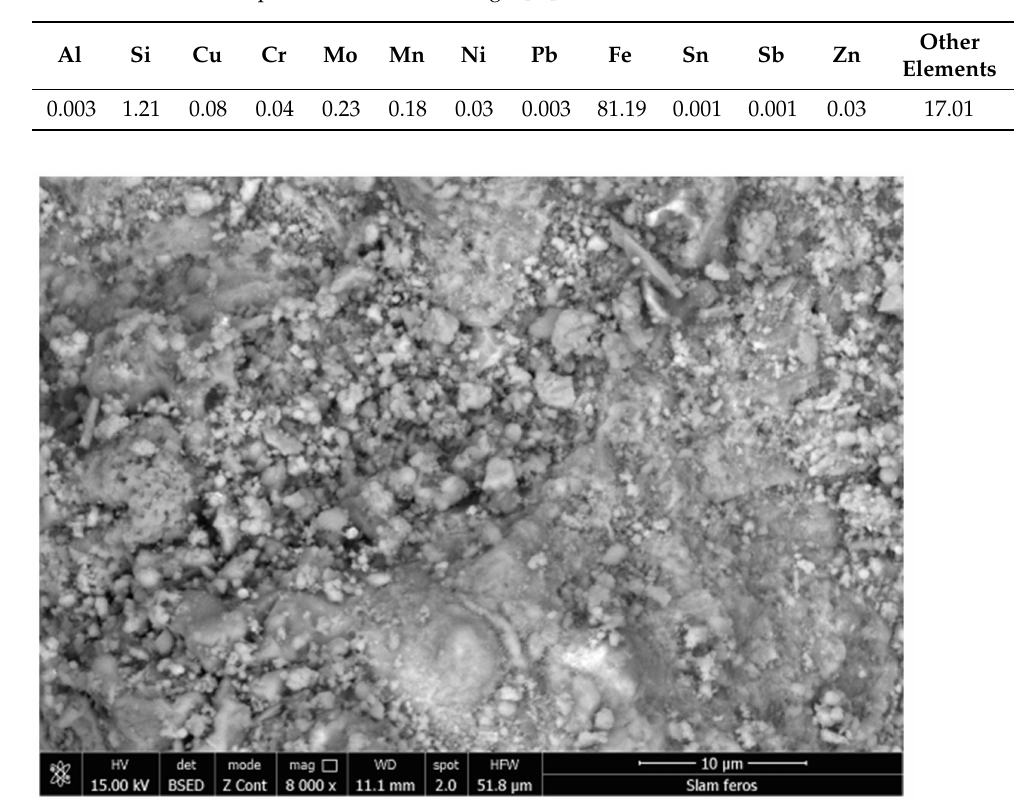
Figure 7. SEM images for ferrous sludge, 8000 ×